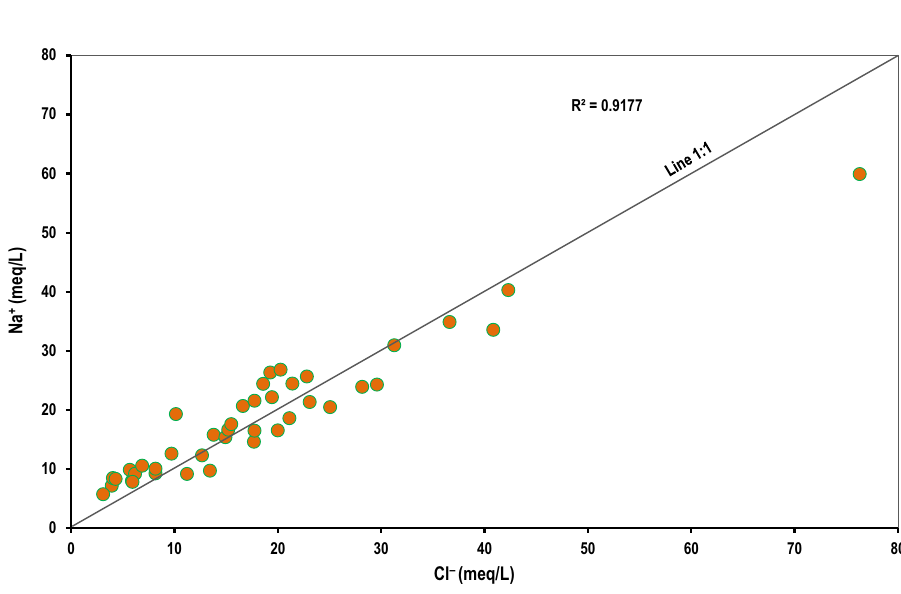
Fig. 4 Plot of Cl – versus Na + + K + in groundwater sam- ples from the study